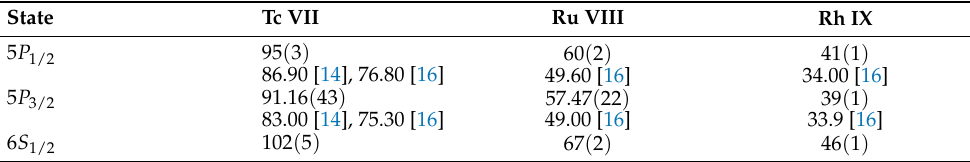
Table 6. The estimated lifetimes τ (in ps) for 5 P 1/2,3/2 and 6 S 1/2 states of Tc VII, Ru VIII and Rh IX ions and their values from available data in the literature. Uncertainties are given in